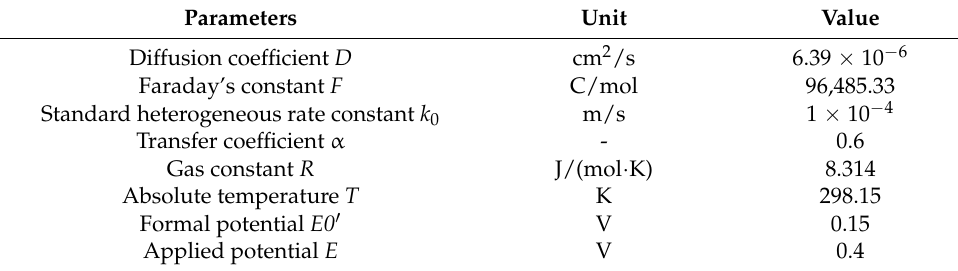
Table 2. Boundary conditions used in the simulations.